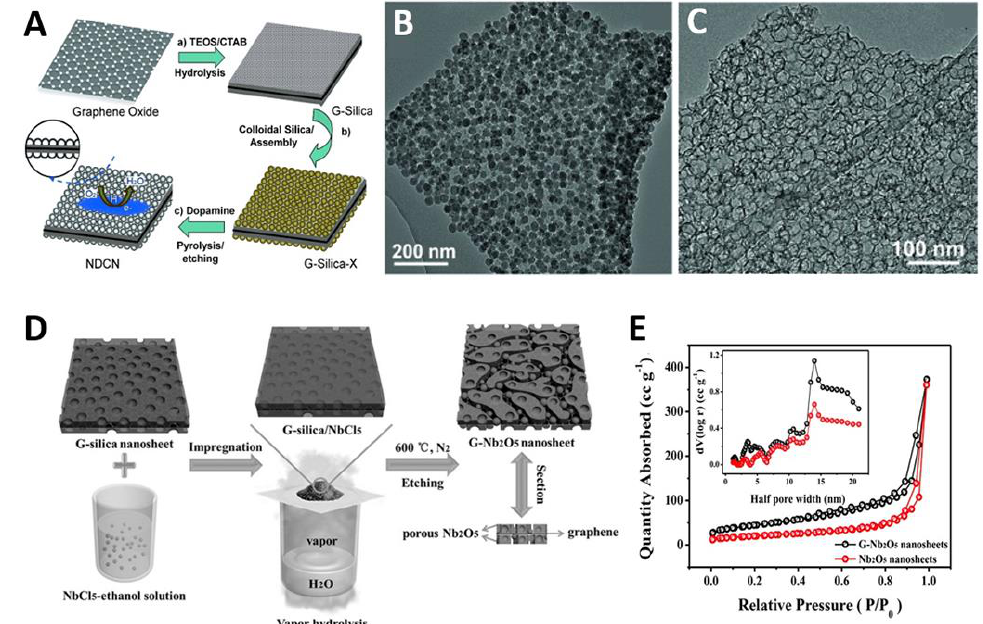
Figure 3. ( A ) Scheme of the synthesis of N-doped mC/G. ( B , C ) TEM images of mSiO 2 /G and inverse-replicated N-doped mC/G. ( A – C ) Reprinted with permission from Ref. [72], Copyright (2014) John Wiley and Sons. ( D ) Scheme of the preparation of Nb 2 O 5 /G nanosheets. ( E ) N 2 adsorption/desorption isotherms of Nb 2 O 5 and Nb 2 O 5 /G nanosheets. ( D , E ) Reprinted with permission from Ref. [77], Copyright (2016) John Wiley and Sons.